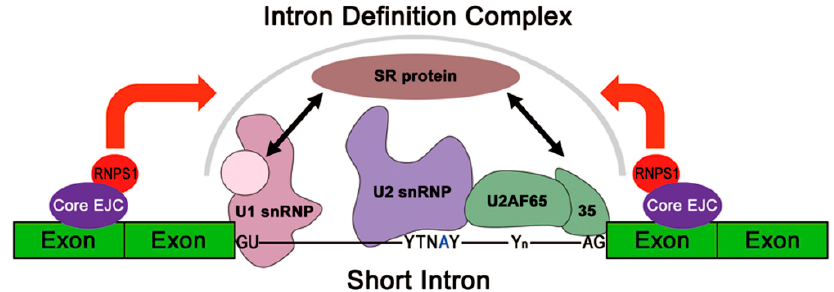
Figure 6. A model of EJC mediated splicing activation. RNPS1 and other EJC associated splicing regulators interact with the core EJC and recruit general splicing factors to essential splicing elements of specific short introns, leading to the efficient or stable formation of an intron definition complex.